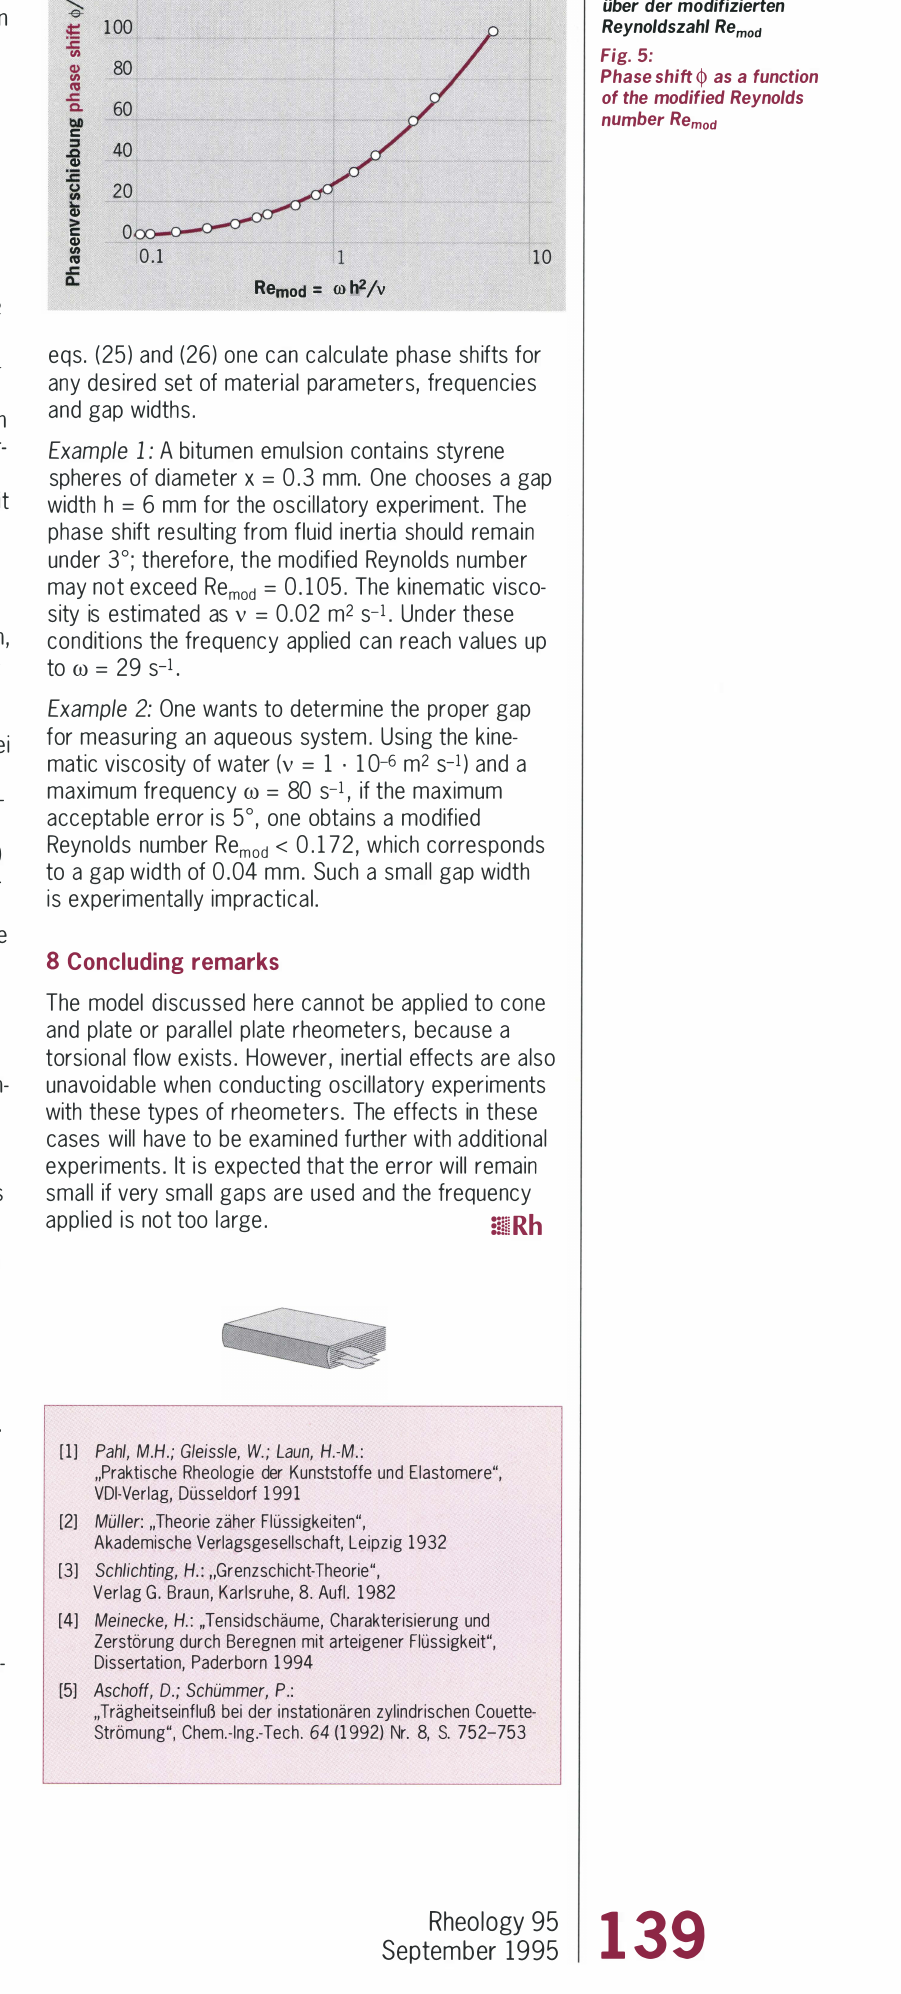
Fig. 5: Phase shift <1> as a